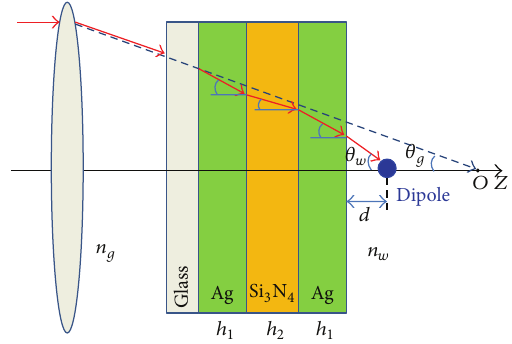
Figure 1: Focusing of excitation light passing through the multilayer